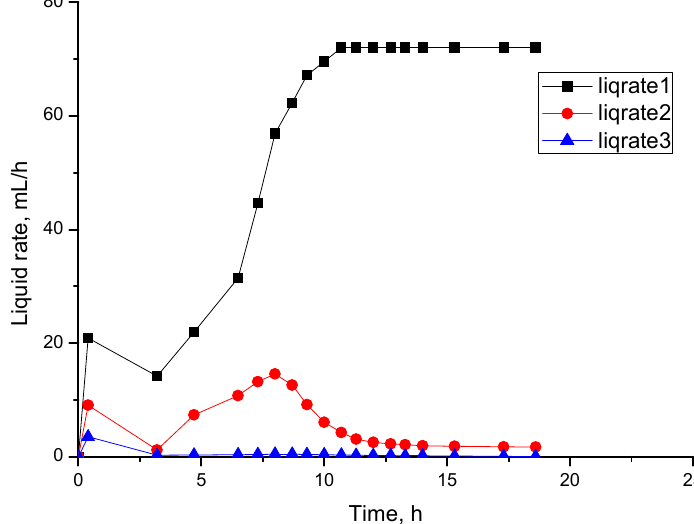
Figure 4. Liquid production rate curves in each coreholder with time.